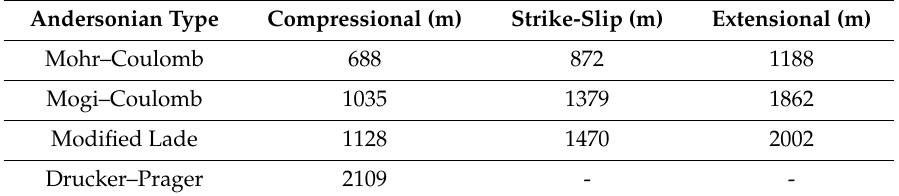
Table 4. Depths at the positive net pressure required to prevent shear